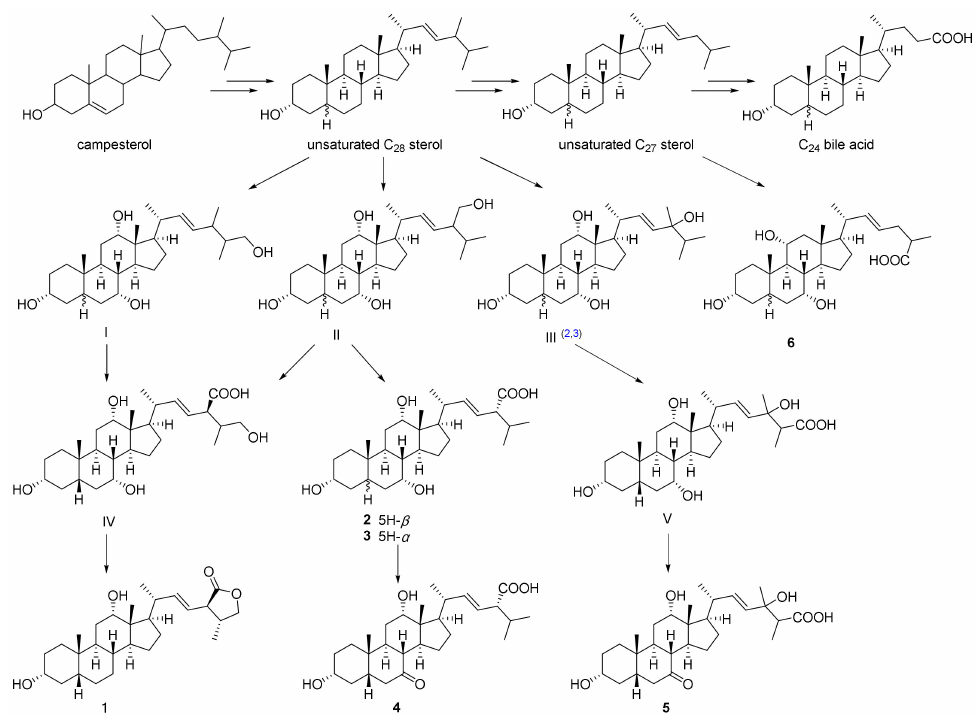
Figure 6. The plausible biosynthesis pathway of bufolic acids ( 1 – 6 ). The major pathway involves campesterol → unsaturated C 28 sterol → unsaturated C 27 sterol → C 24 bile